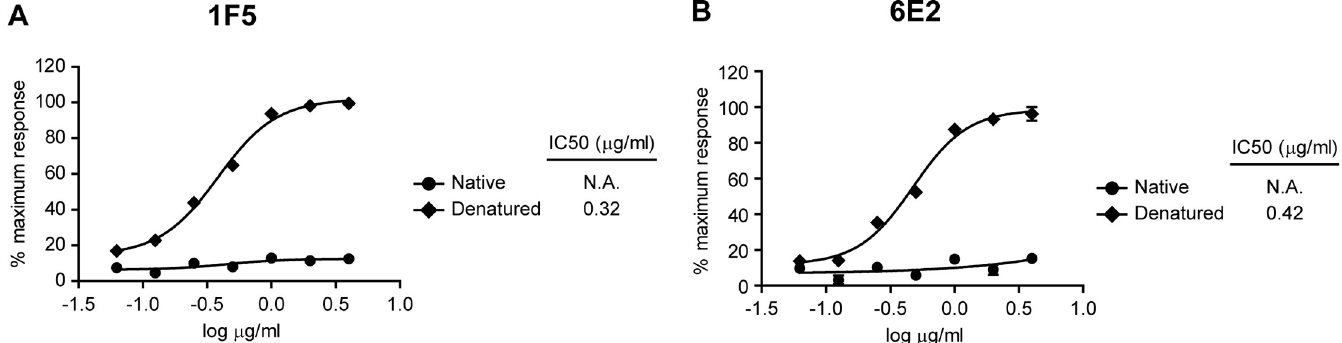
Fig 1. Relative affinity of 1F5 and 6E2 mAbs for the denatured monomeric and the native hexameric ZNS1 conformations. Standard curves of denatured monomeric or native hexameric HEK293-expressed ZNS1 detected by iELISA with (A) 1F5 or (B) 6E2 mAbs. Each point of the curve represents mean ± SEM of three sample replicates. IC50 values of the mAbs are